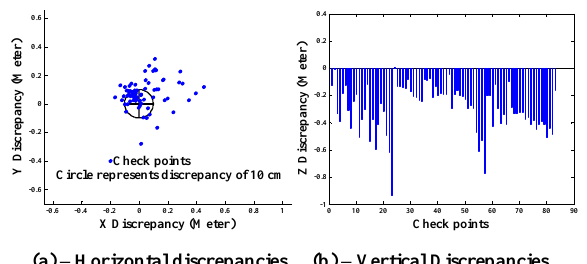
Figure 3. Horizontal e vertical discrepancies of check points (first block) from ISO experiment without control points and IOP from photogrammetric company